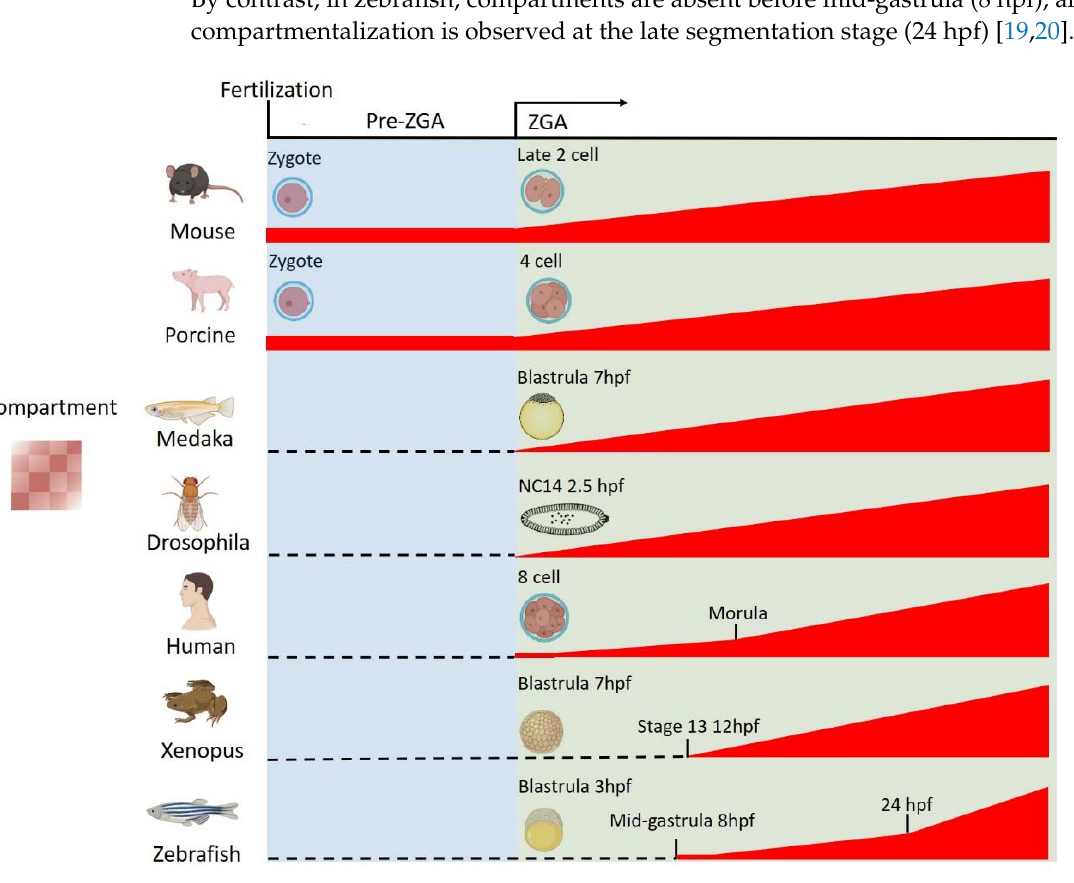
Figure 3. A/B compartment reprogramming during the early development in different species. The emergence timing of A/B compartments in early embryos is highly species-specific. In mouse and porcine embryos, A/B compartments already exist before ZGA and are gradually enhanced after ZGA. In medaka and drosophila, A/B compartments begin to establish at ZGA. In human, only weak A/B compartments exist at ZGA and become stronger from the morula stage onwards. By contrast, the establishment of A/B compartments mainly occurs after ZGA in xenopus and zebrafish embryos. Taken together, these results show a drastic reorganization of 3D chromatin structure during embryogenesis in different species although the emergence timing varies